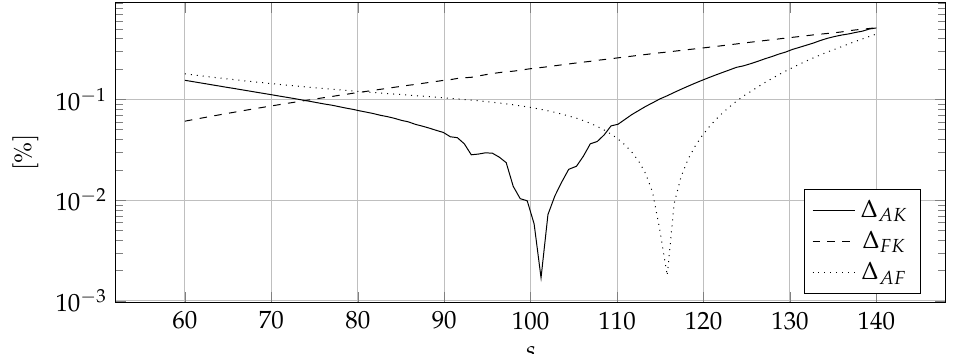
Figure 8. The influence of the sharpness parameter s on ∆ AK , ∆ FK , and ∆ AF error measures for 80 collocation points.